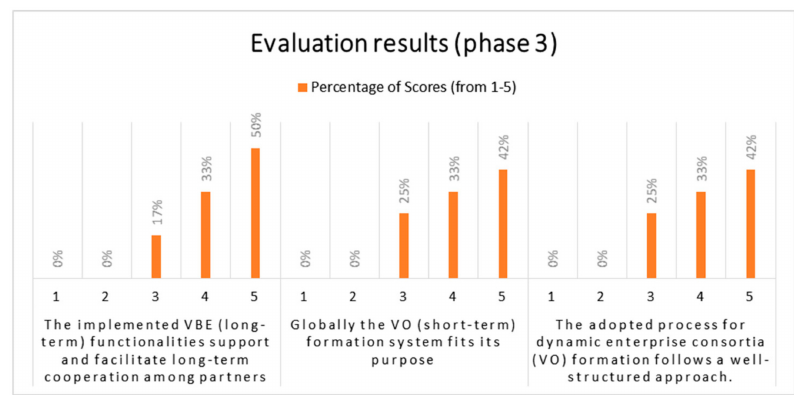
Figure 10. Assessment of VBE/VO functionalities by the solar energy